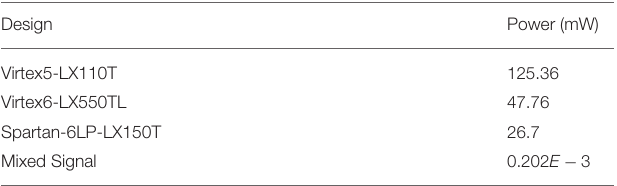
TABLE 3 | Power consumption of digital and mixed signal implementations of 30 neurons hybrid reservoir.